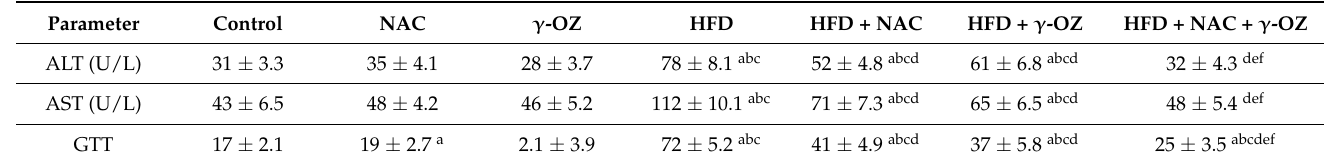
Table 2. γ -Oryzanol (OZ) and N-acetylcysteine (NAC) and their combination reduce liver function enzymes in high-fat-diet (HFD)-fed